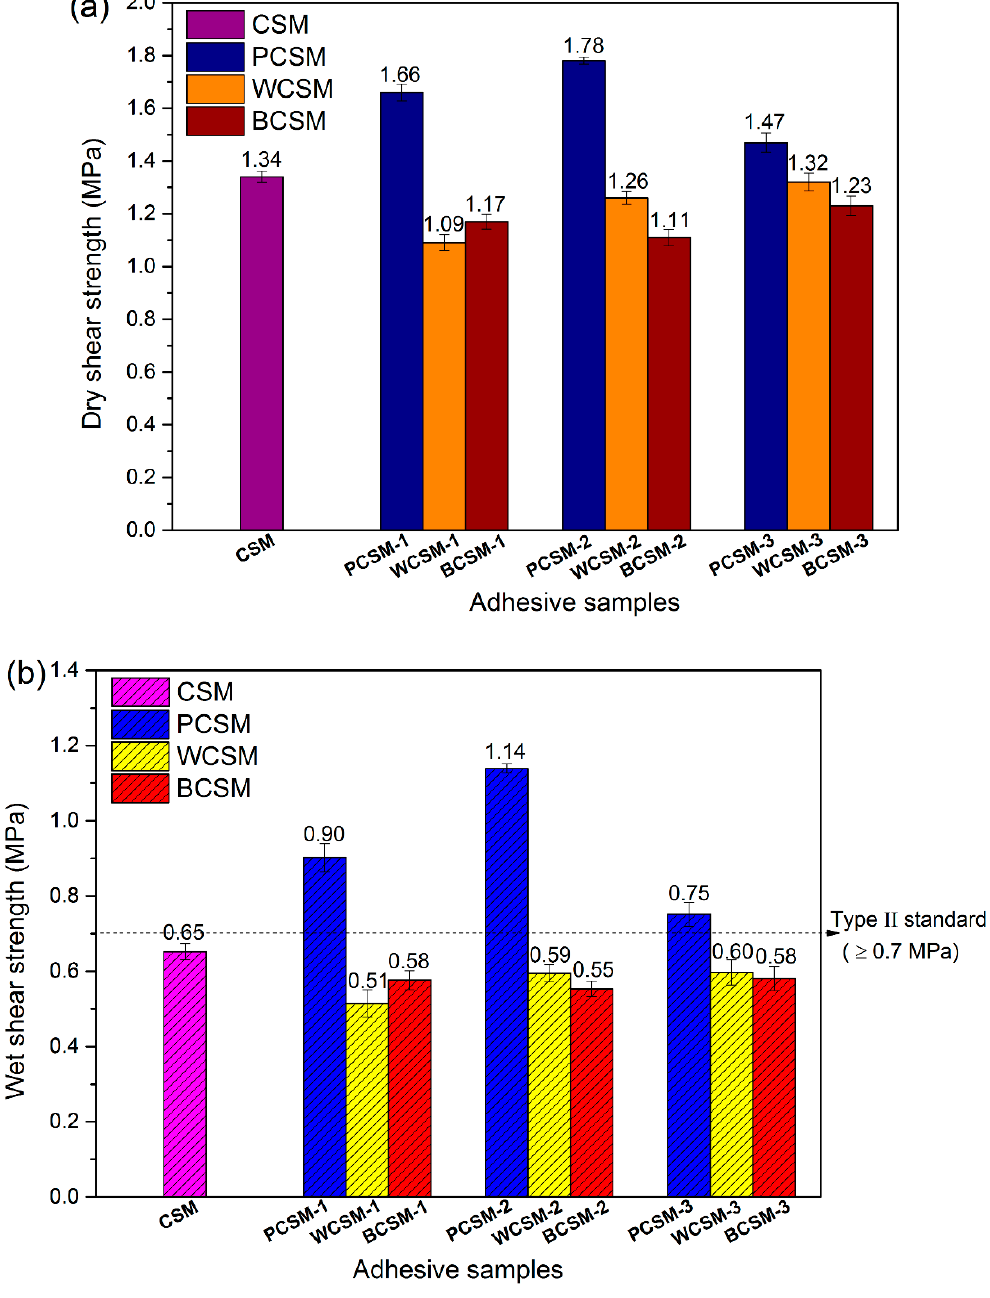
Figure 6. Dry ( a ) and wet ( b ) shear strengths of CSM, PCSM (1 – 3), WCSM (1 – 3), and BCSM (1 – 3) adhesives.